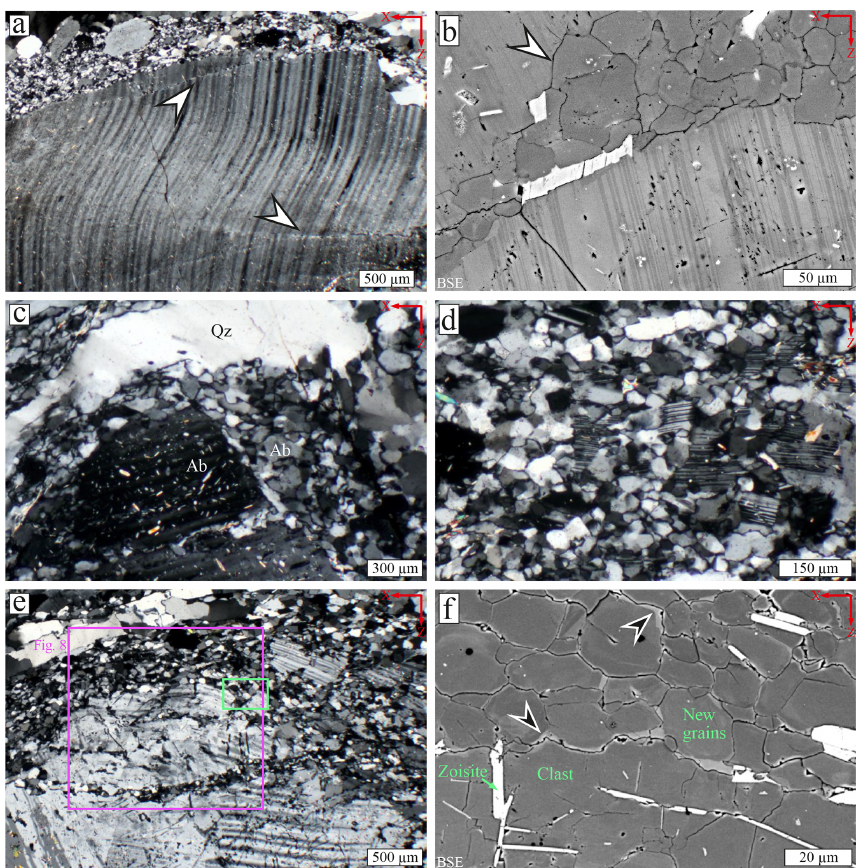
Figure 7. (a) Polarized light micrograph (crossed polarizers) and (b) BSE image of bent and kinked twins in albite porphyroclast, sample FH5. New albite grains occur along fractures parallel to kink band boundaries (arrows). (c) Polarized light micrograph (crossed polarizers), showing fragmented albite porphyroclast partly replaced by new grains and surrounded by the quartz layer, sample FH5. (d) Polarized light micrograph (crossed polarizers) showing twinned albite fragments surrounded by fine-grained albite matrix, sample FH5. (e) Polarized light micrograph (crossed polarizers) of twinned and fractured albite porphyroclast, sample UP3. The green box indicates the area of the BSE image in panel (f) ; the violet box indicates the EBSD map shown in Fig. 8. (f) BSE image showing new albite grains adjacent to the albite porphyroclast. New grains often have an outer rim of less albitic plagioclase, up to An20 (arrows). The bright phases are zoisite